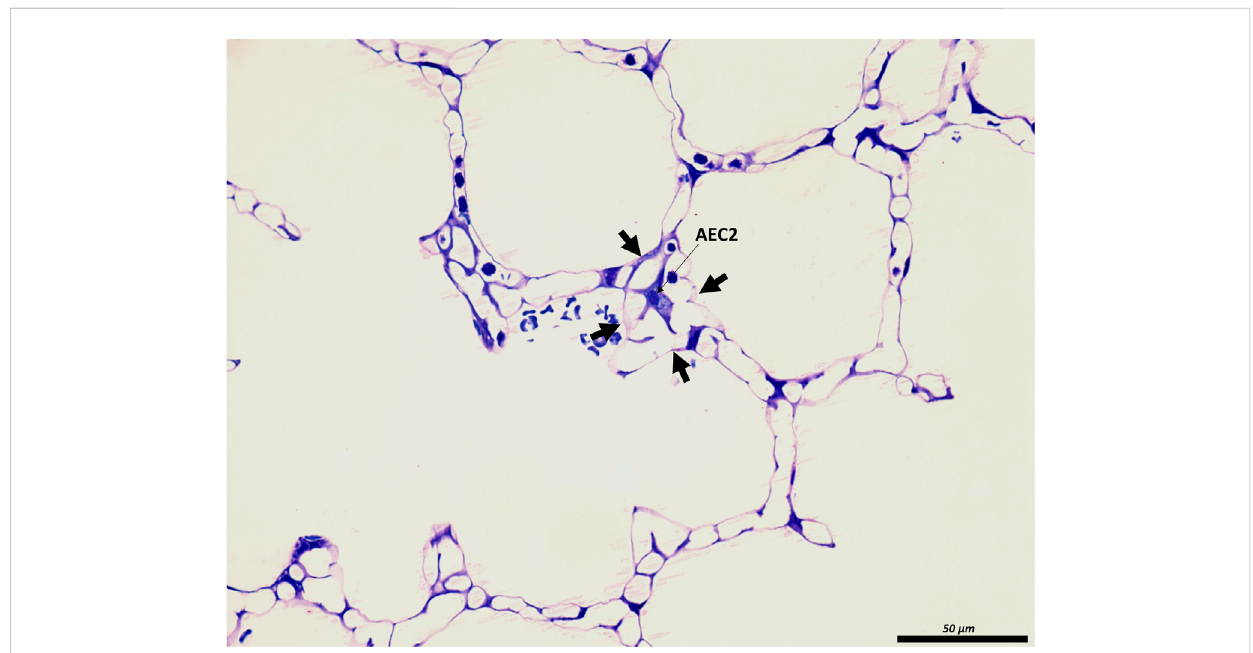
FIGURE 3 Thejunctionofinter-alveolarsepta:Ahealthyratlungwas fi xed invivo byvascularperfusion via thevenacavacaudalisatanairwayopeningpressure of10 cmH 2 Oon expirationafter two recruitment maneuvers(3 spause at30cmH 2 O)(Knudsenetal.,2018).Inthemiddle oftheseptal junction(arrows), analveolarepithelialtypeIIcell(AEC2)ispresent.Whilemostoftheinteralveolarseptacontainasinglelayerofthealveolarcapillarynetwork,thereappear to be two layers at this junction surrounding the AEC2, most likely due to pleating that causes piling up of the interalveolar